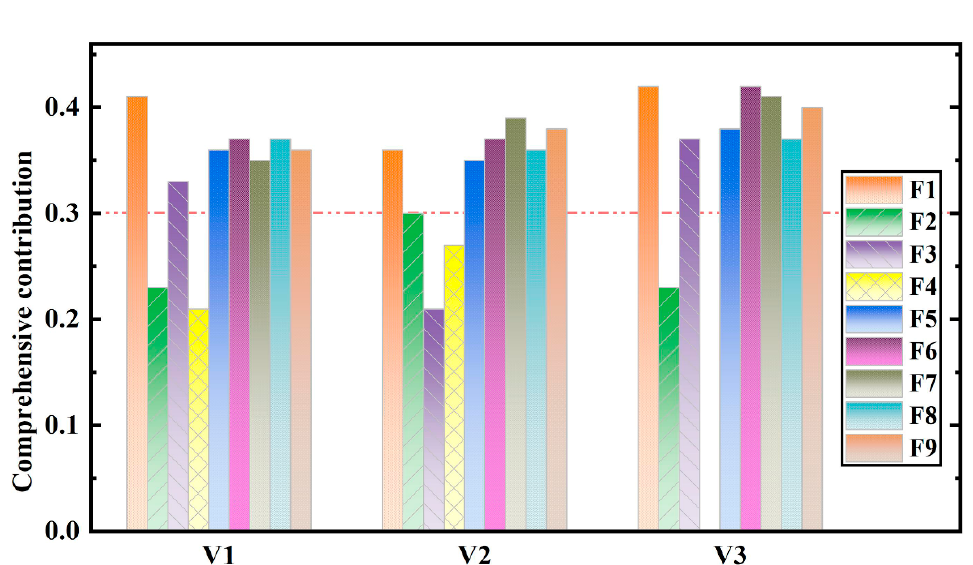
Figure 9. Comprehensive contribution of each factor according to the association rules (V1: Low monthly velocity; V2: Medium monthly velocity; V3: High monthly velocity; F1: Monthly average water level; F2: Maximum monthly daily drop in water level; F3: Maximum monthly daily rise in water level; F4: Monthly fluctuation of the water level; F5: Bimonthly fluctuation of the water level; F6: Maximum monthly effective continuous rainfall; F7: Cumulative monthly rainfall; F8: Cumulative bimonthly rainfall; F9: Maximum monthly daily rainfall).